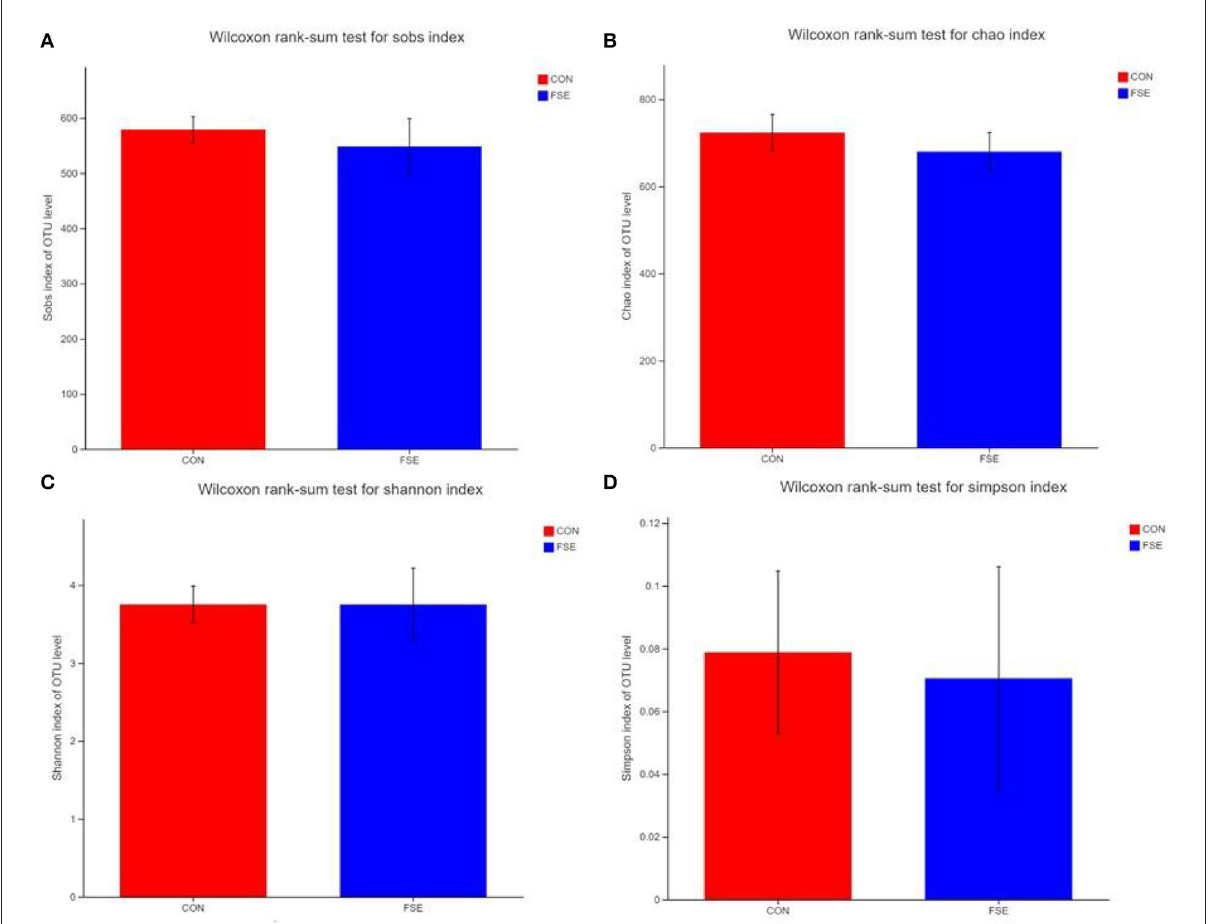
FIGURE1 Effects of Forsythia suspensa extract on α -diversity in the colon digesta of finishing pigs (A) Wilcoxon rank sum test for sob index; (B) Wilcoxon rank sum test for Chao index; (C) Wilcoxon rank sum test for the Shannon index; (D) Wilcoxon rank sum test for the Simpson index; CON: control; FSE: Forsythia suspensa extract. n =